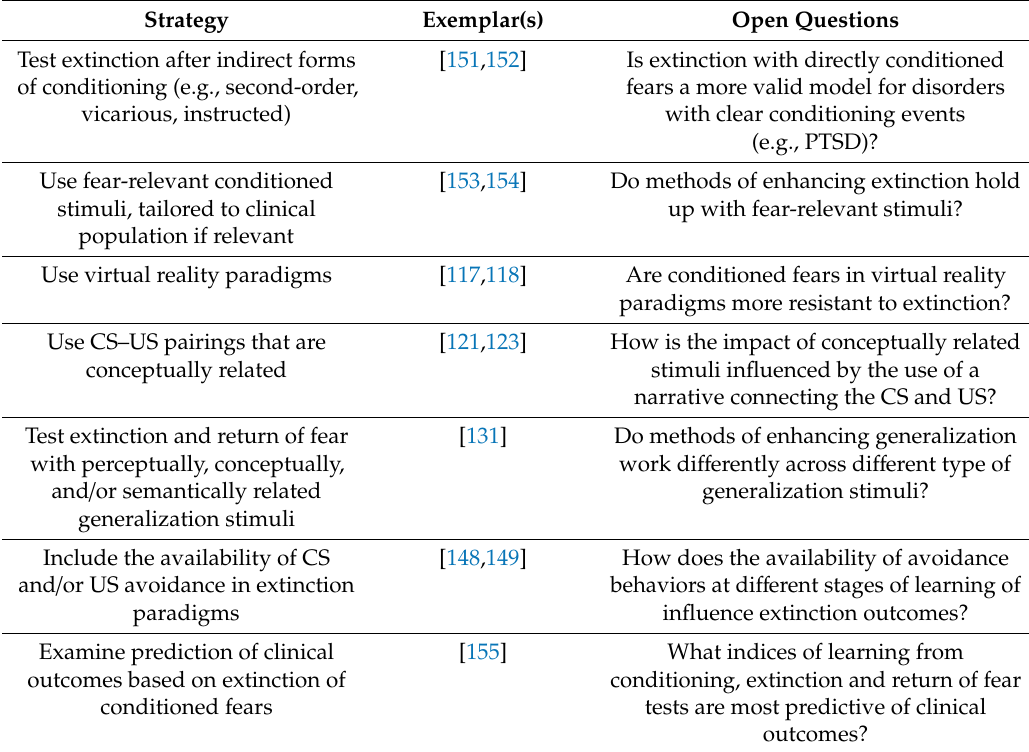
Table 1. Strategies for enhancing the external validity of extinction paradigms. CS,